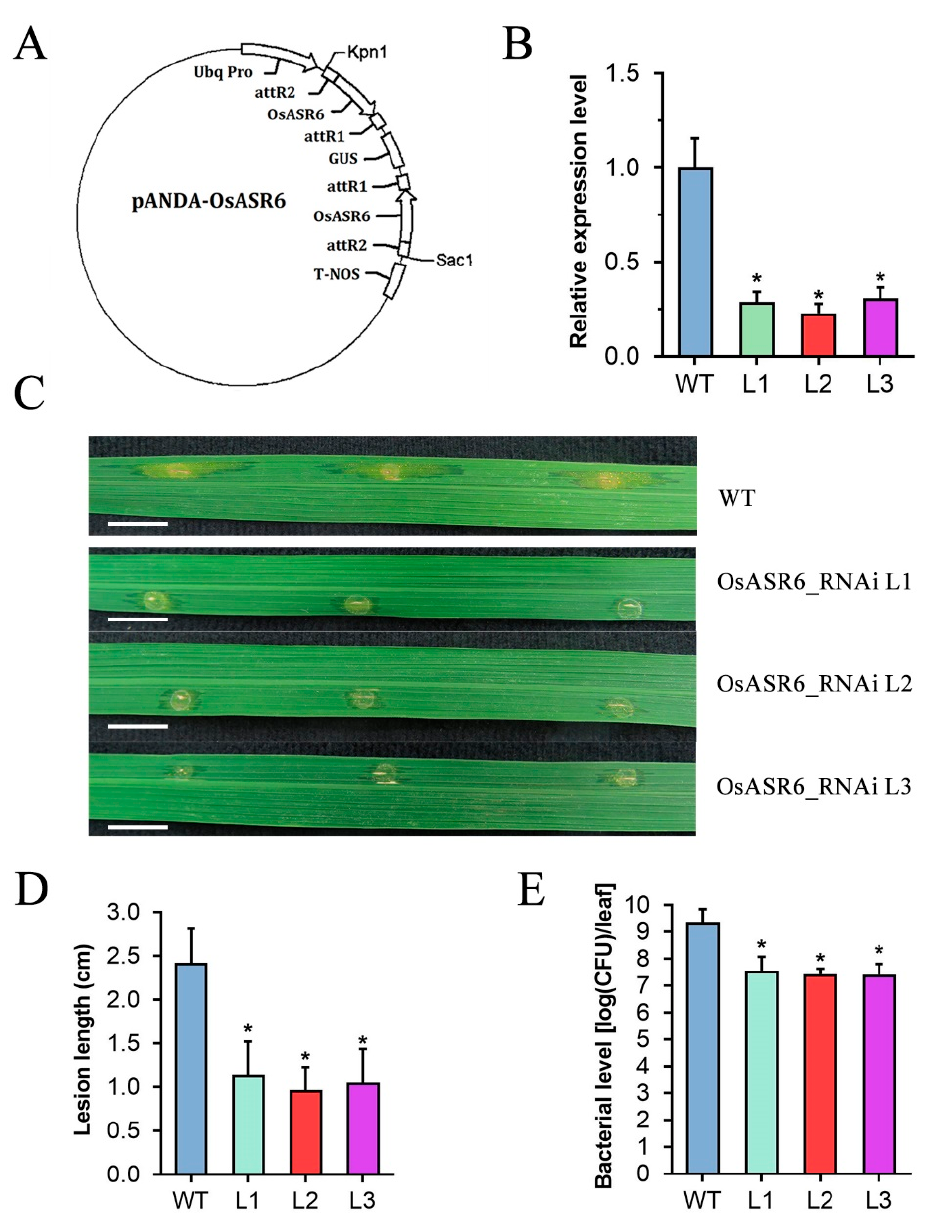
Figure 2. OsASR6 strongly negatively modulates rice resistance to Xoc . ( A ) Schematic representation of pANDA-OsASR6 vector. ( B ) OsASR6 gene expression of 5-week-old OsASR6-RNAi lines. ( C ) Rice bacterial leaf streak symptoms in WT and OsASR6-RNAi T 2 lines at 10 d post inoculation (dpi) with Xoc strain oxy04 (OD 600 = 1) by leaf infiltration method. Bar: 1 cm. ( D ) Statistical analysis of lesion length at 10 dpi. ( E ) Statistical analysis of bacterial level in planta at 10 dpi. Data were analyzed by Student’s t -test and shown as the mean ± SD. Asterisks indicate significant difference between data from OsASR6-RNAi lines (L) and those from wild-type plants (WT) (* p < 0.05).